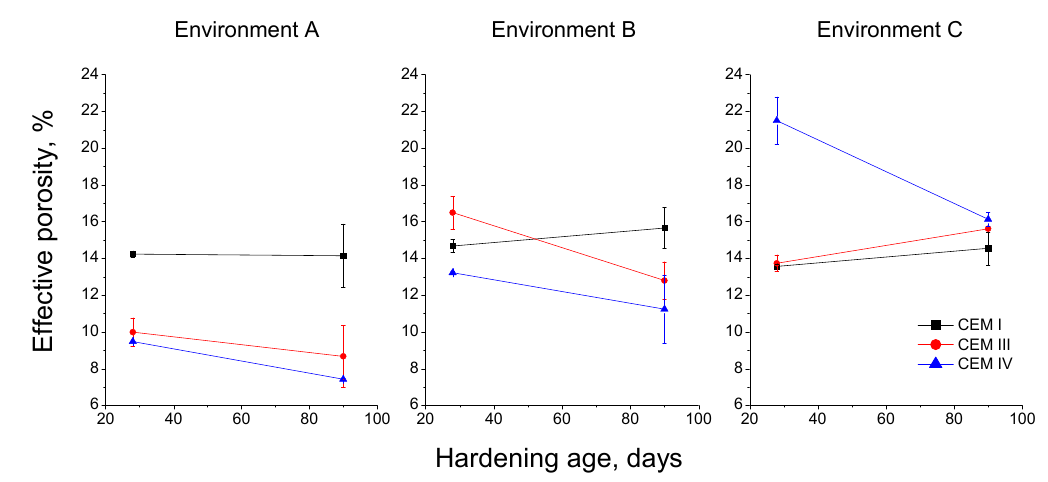
Figure 13. Results of effective porosity obtained for concretes the studied mortars.